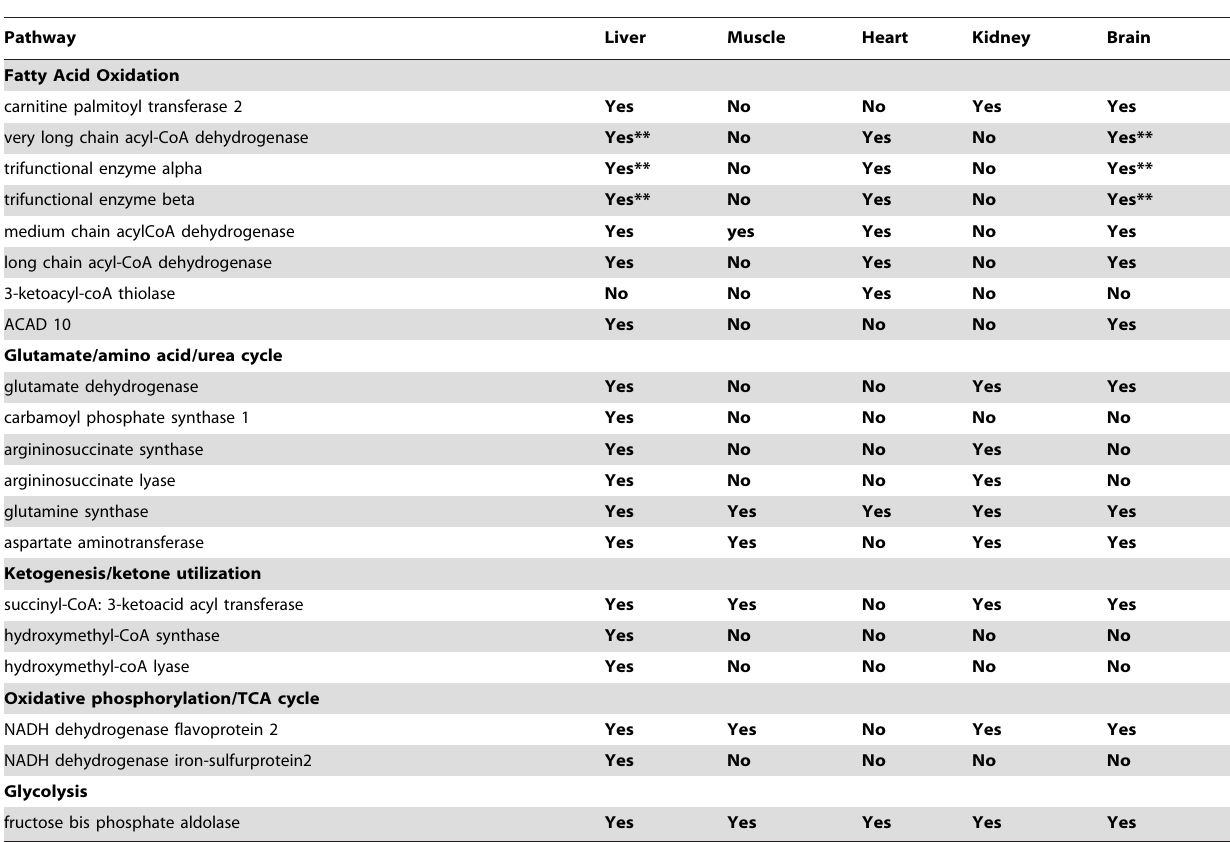
Table 2. Proteins found in association with SCHAD by